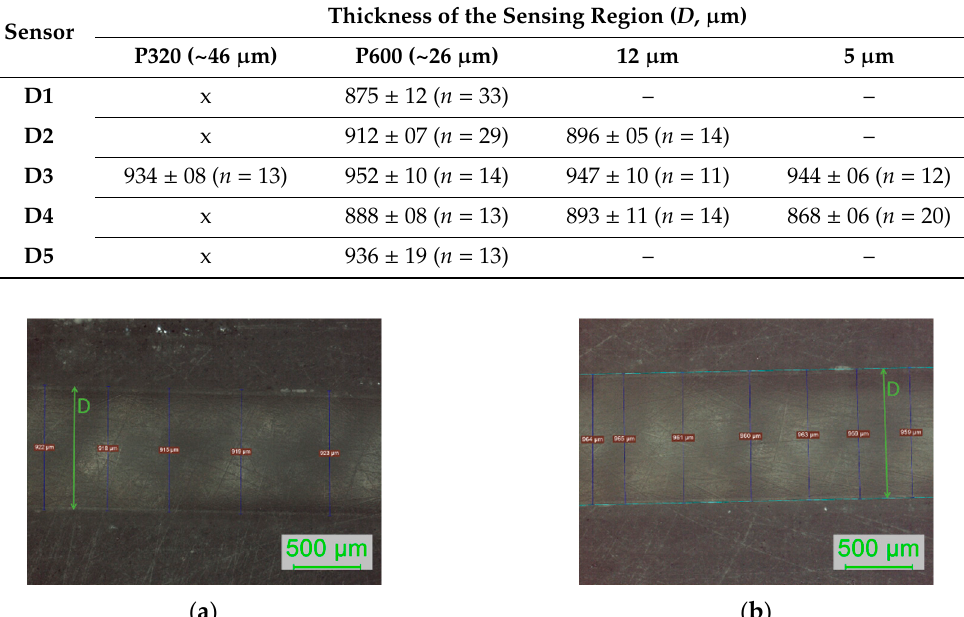
Figure 6. Optical microscopy images (in reflection, with a 5× objective lens): measurements of the thickness of the sensing region after Polishing 2 (P600) for sensor D2 ( a ) and sensor D3 ( b ). Table 3. D-shaped POF sensors: thickness of the sensing region after the polishing procedures, average value and standard deviation ( (cid:1866) is the number of measurements performed).